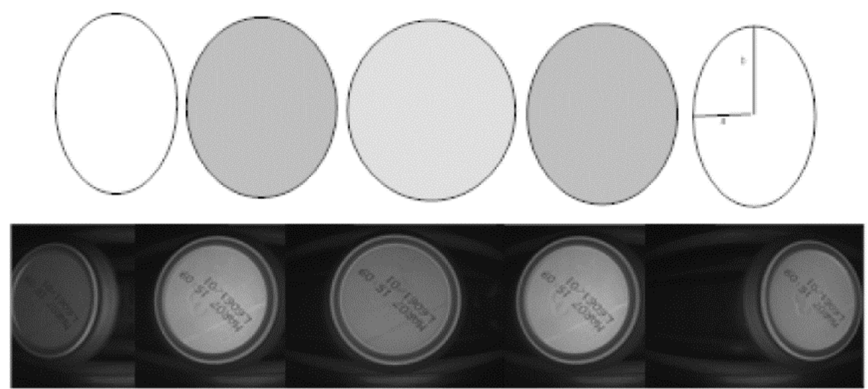
Figure 2. Selecting the best image for the can. The best image is the one in which the can is centred.